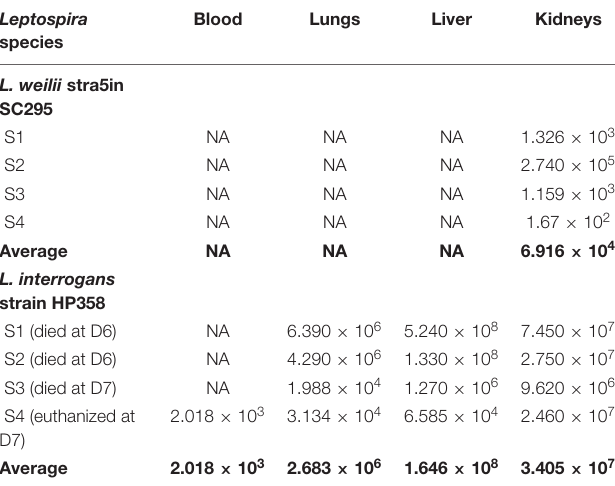
TABLE 4 | The leptospiral load in organs infected with L. weilii strain SC295 and L. interrogans strain HP358. Leptospira Blood Lungs Liver species